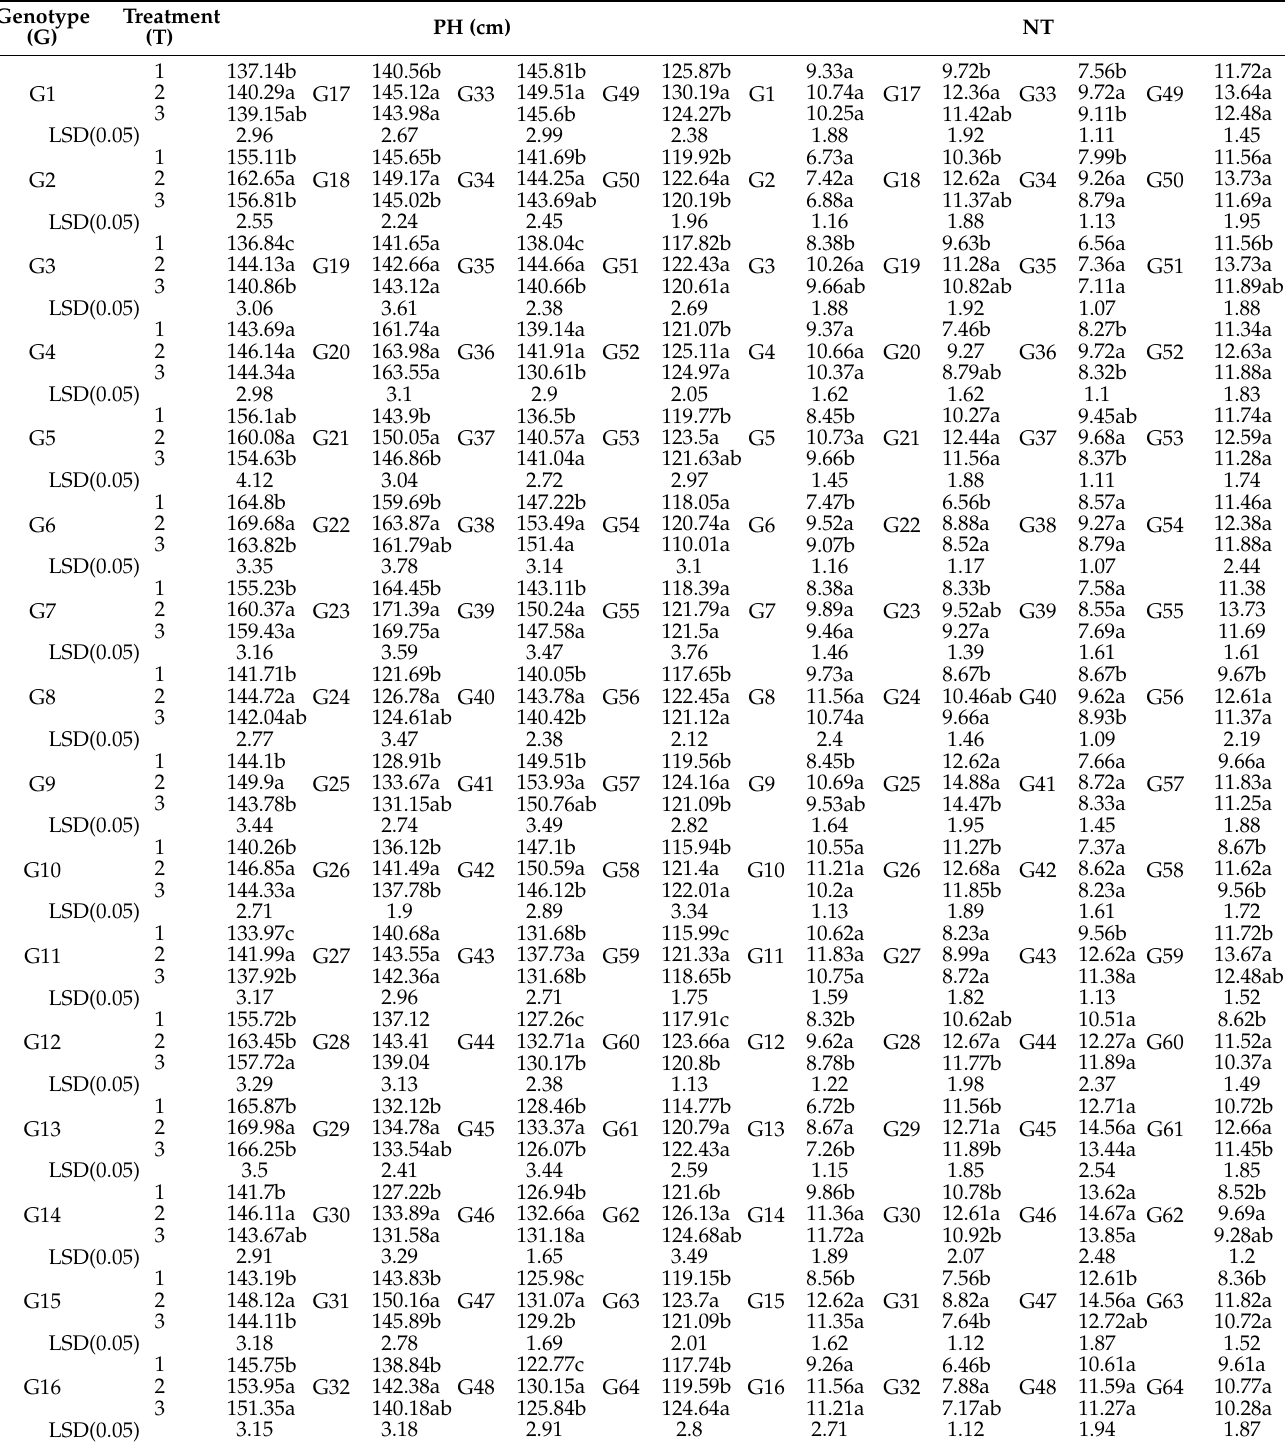
Table 5. Plant height and number of tillers per plant of 64 rice genotypes as influenced by treatment and genotype (pooled over two